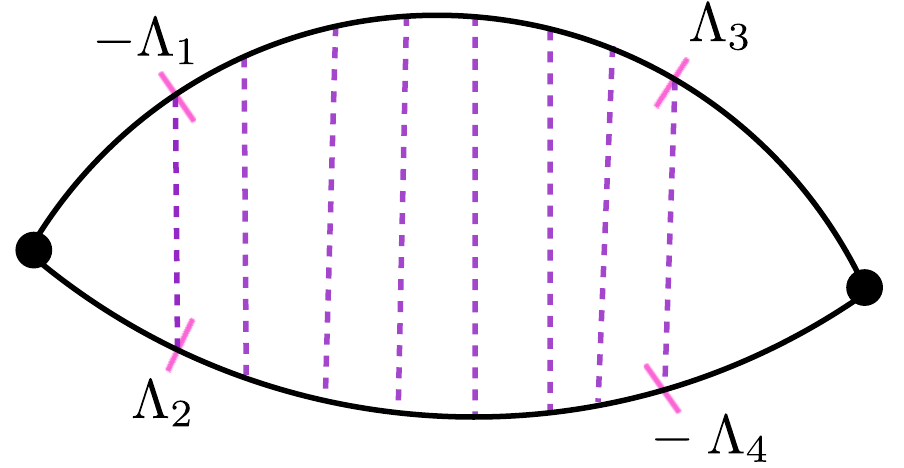
Figure 2 . Ladder resummation over part of the 2-cusped loop, de(cid:12)ning G ((cid:3) 1 ; (cid:3) 2 ; (cid:3) 3 ; (cid:3) 4 ). Note that the expression for this is divergent for resummation up to either of the